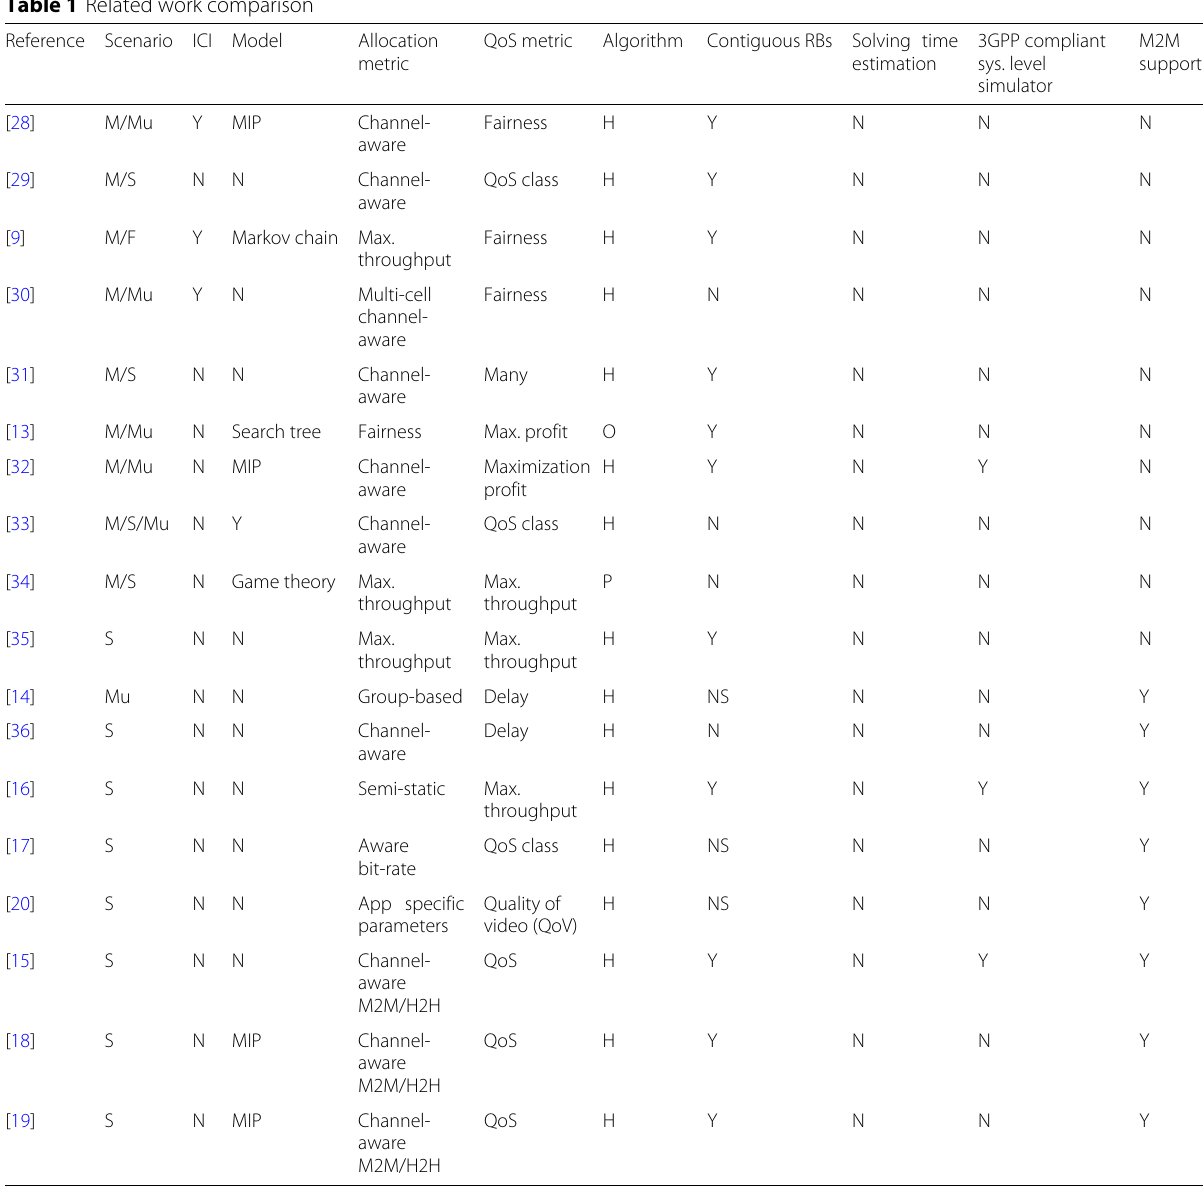
Table 1 Related work comparison Reference Scenario ICI